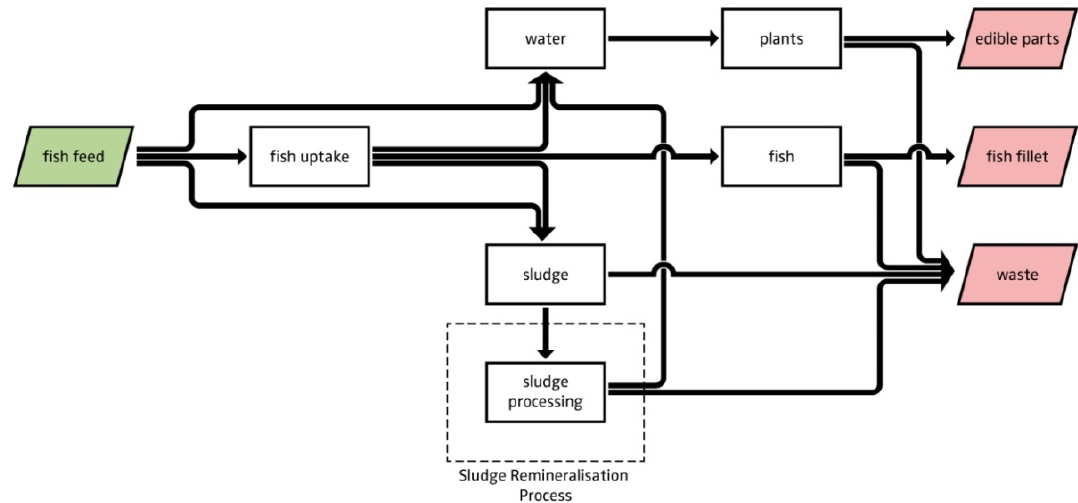
Figure 8. The water flow chart shows the water flows within a DAPS system. It can be seen, that the implementation of an ANRC has an impact on the water availability in the system. Even though, the water loss through evapotranspiration outweighs the loss through sludge removal, it is still an important step towards closing the cycle.